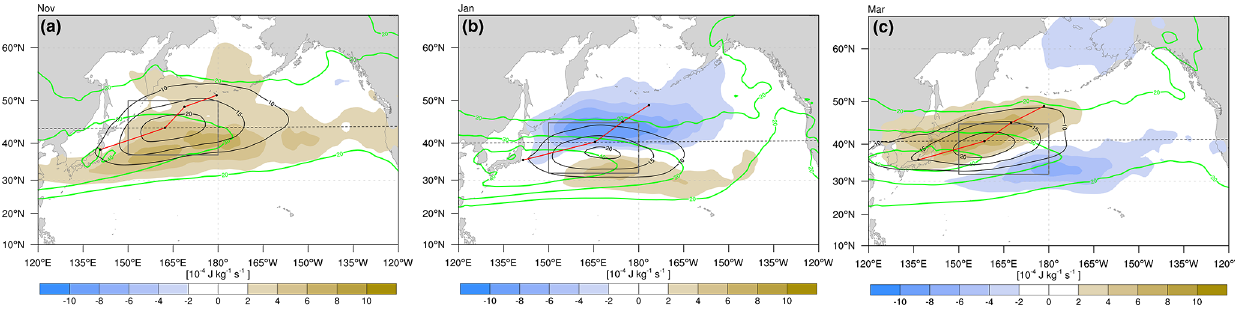
Figure 7. Monthly mean baroclinic conversion at 500hPa (black contours, 10 − 4 Jkg − 1 s − 1 ), its change relative to the previous month (color shading), and a target region (black box) that shifts with the maximum in the mean baroclinic conversion for (a) November (150–180 ◦ E, 37–50 ◦ N), (b) January (150–180 ◦ E, 32–45 ◦ N), and (c) March (150–180 ◦ E, 33–46 ◦ N). The red line indicates the mean location of cyclone tracks that propagate into the target region from upstream. The black dots along the mean track indicate the mean location of cyclogenesis, the location of maximum deepening (6-hourly SLP change), the location of maximum intensity (minimum SLP), and the location of cyclolysis. Additionally shown is the monthly mean baroclinicity (green contours; 25 to 45 × 10 − 6 s − 1 by steps of 5 × 10 − 6 s − 1 ). The latitude of the maximum deepening is indicated by a black dashed contour.